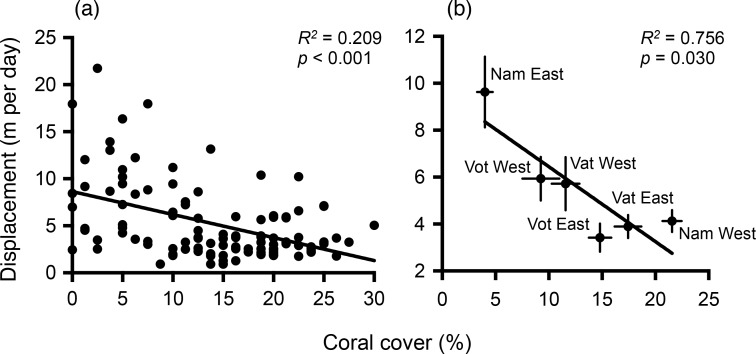
Acanthaster displacement is negatively correlated with local coral cover.(a) Relationship between individual Acanthaster displacement between consecutive days (m day-1) and coral cover (%) at each individual’s release location along MPA borders. (b) Relationship between coral cover (mean % ± SE) and Acanthaster displacement between consecutive days (m day-1; mean ± SE) when pooled by MPA border. See Fig 1 for village site names. Coefficients of regression (R2) and p-values are indicated in the graph. Two data points with extreme Acanthaster displacement values (y1 = 42.65 m, y2 = 34.39 m) at low coral cover (x1 = 0%, x2 = 11.25%) were excluded from analyses after performing an outlier analysis (Jackknife distances) using JMP (Version 11.0.0).